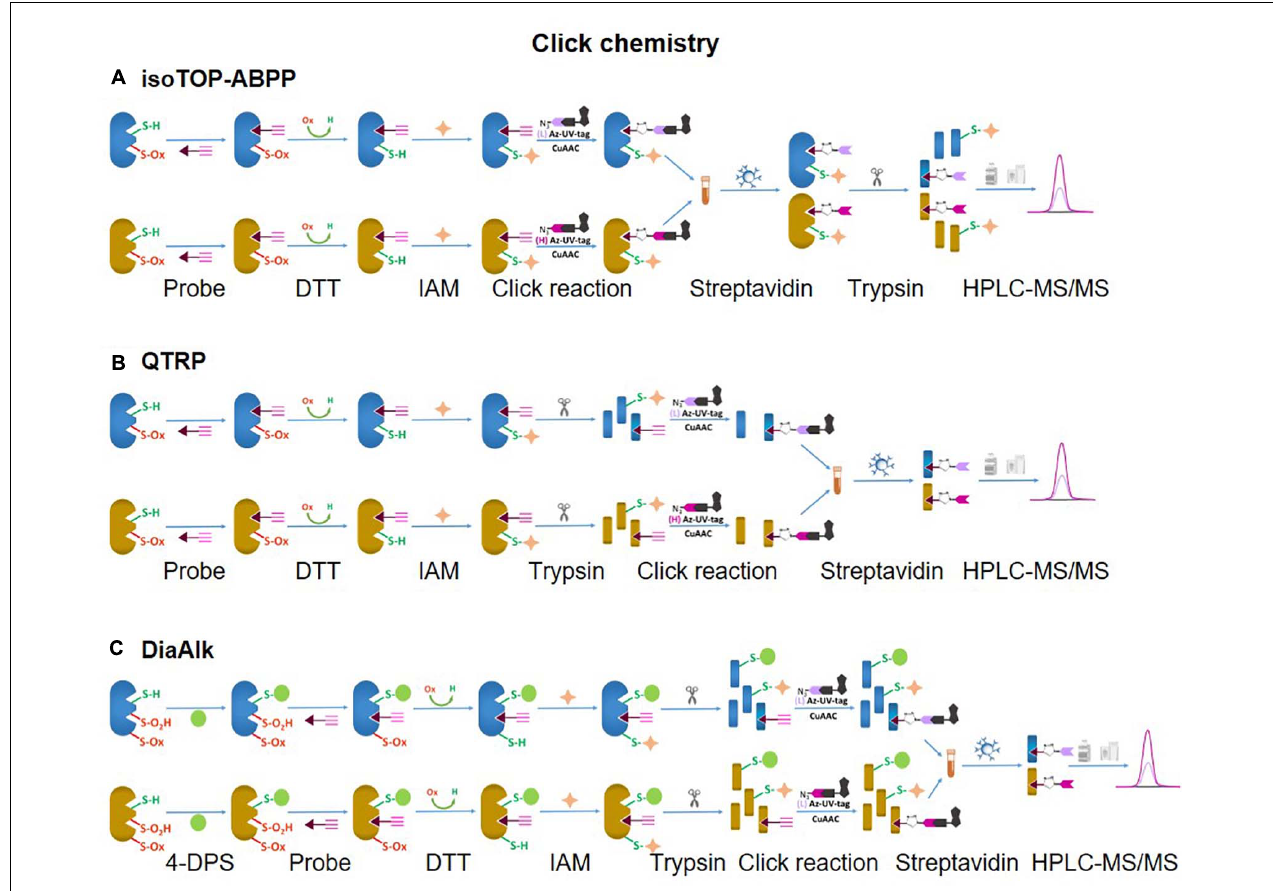
FIGURE 6 | Click chemistry thiol-reactive workflows. (A) isoTOP-ABPP; (B) QTRP; (C) DiAlk. The Oxy-Cys quantitation of these approaches is based on MS1